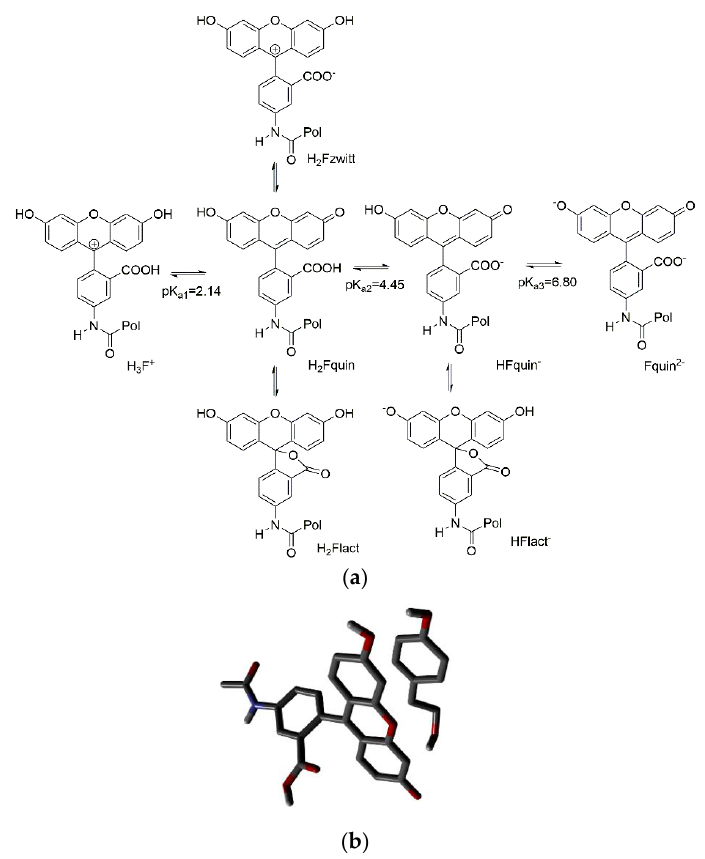
Figure 2. ( a ) Equilibria of fluorescein in water solution [23]; ( b ) optimized geometry of the complex of tyrosol and the H 2 Fquin form of fluorescein.